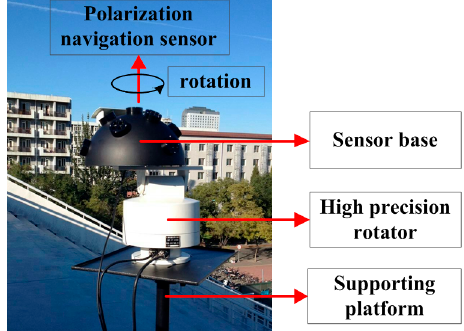
Figure 8. The experiment under clear sky. The tested sensor was aimed at the zenith of the sky dome. It was carried by a high precision rotator which was controlled by a computer. The sensor base was used to fix the orientation of the sensor.